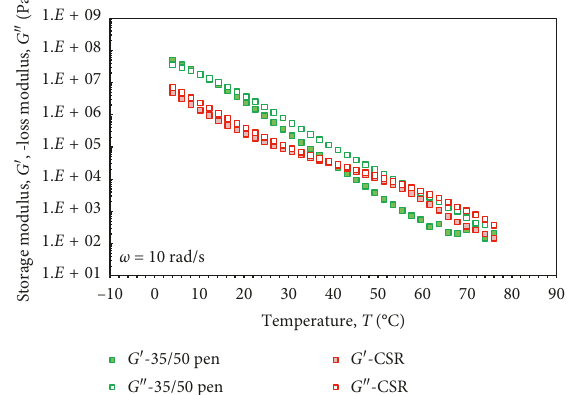
Figure 9: Amplitude sweep experimental test results ( G 35/50 pen.